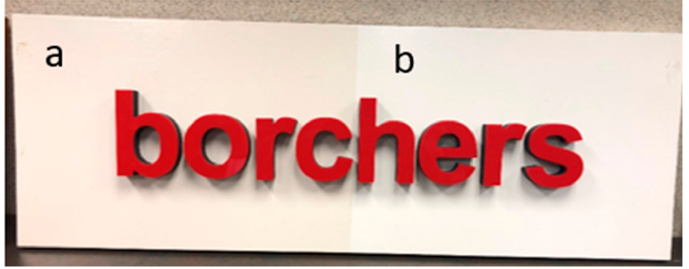
Figure 6. A marketing tool by Borchers showing the real-life effect of yellowing using a white alkyd formulated with a cobalt-soap ( a ) versus BOC ( b ) as the siccative, after storage.